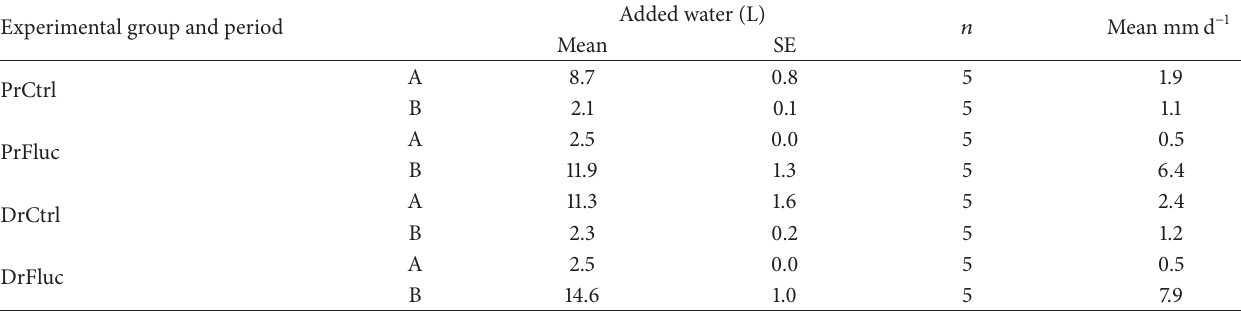
Table 1: Spring water volumes added to each experimental group during the low water table (A) and high water table (B) periods within the five months’ experiment.